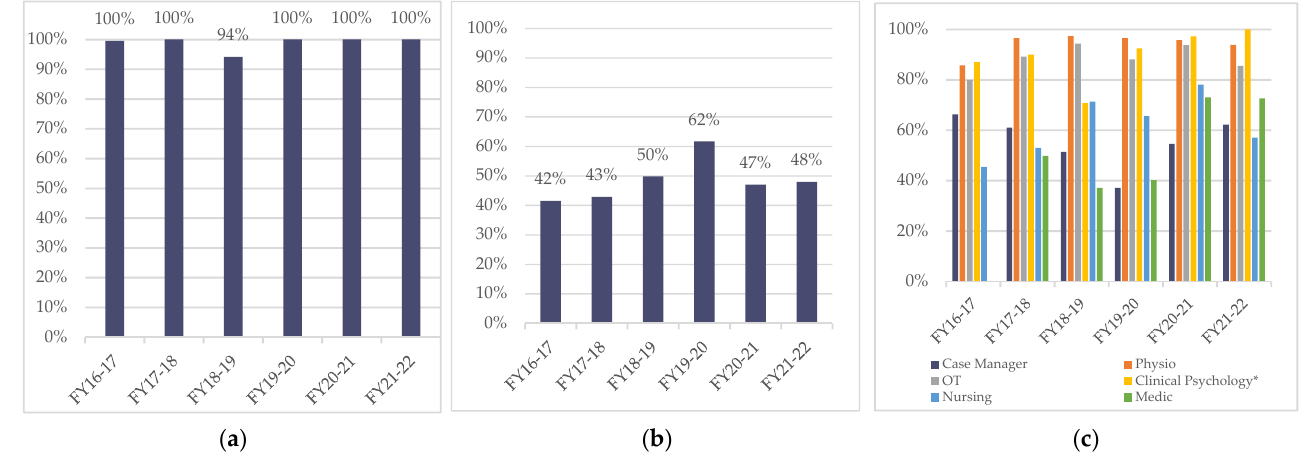
Figure 1. Goal planning participation: ( a ) Annual inpatient attendance at goal planning meetings; ( b ) Annual family attendance at goal planning meetings; ( c ) Annual MDT attendance at goal plan-